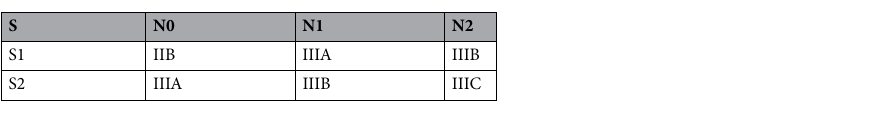
Table 3. T4a CC patients were divided into two groups according to the tumor size: S1 and S2 groups. S was included into staging system, then the new stages were suggested. S: tumor